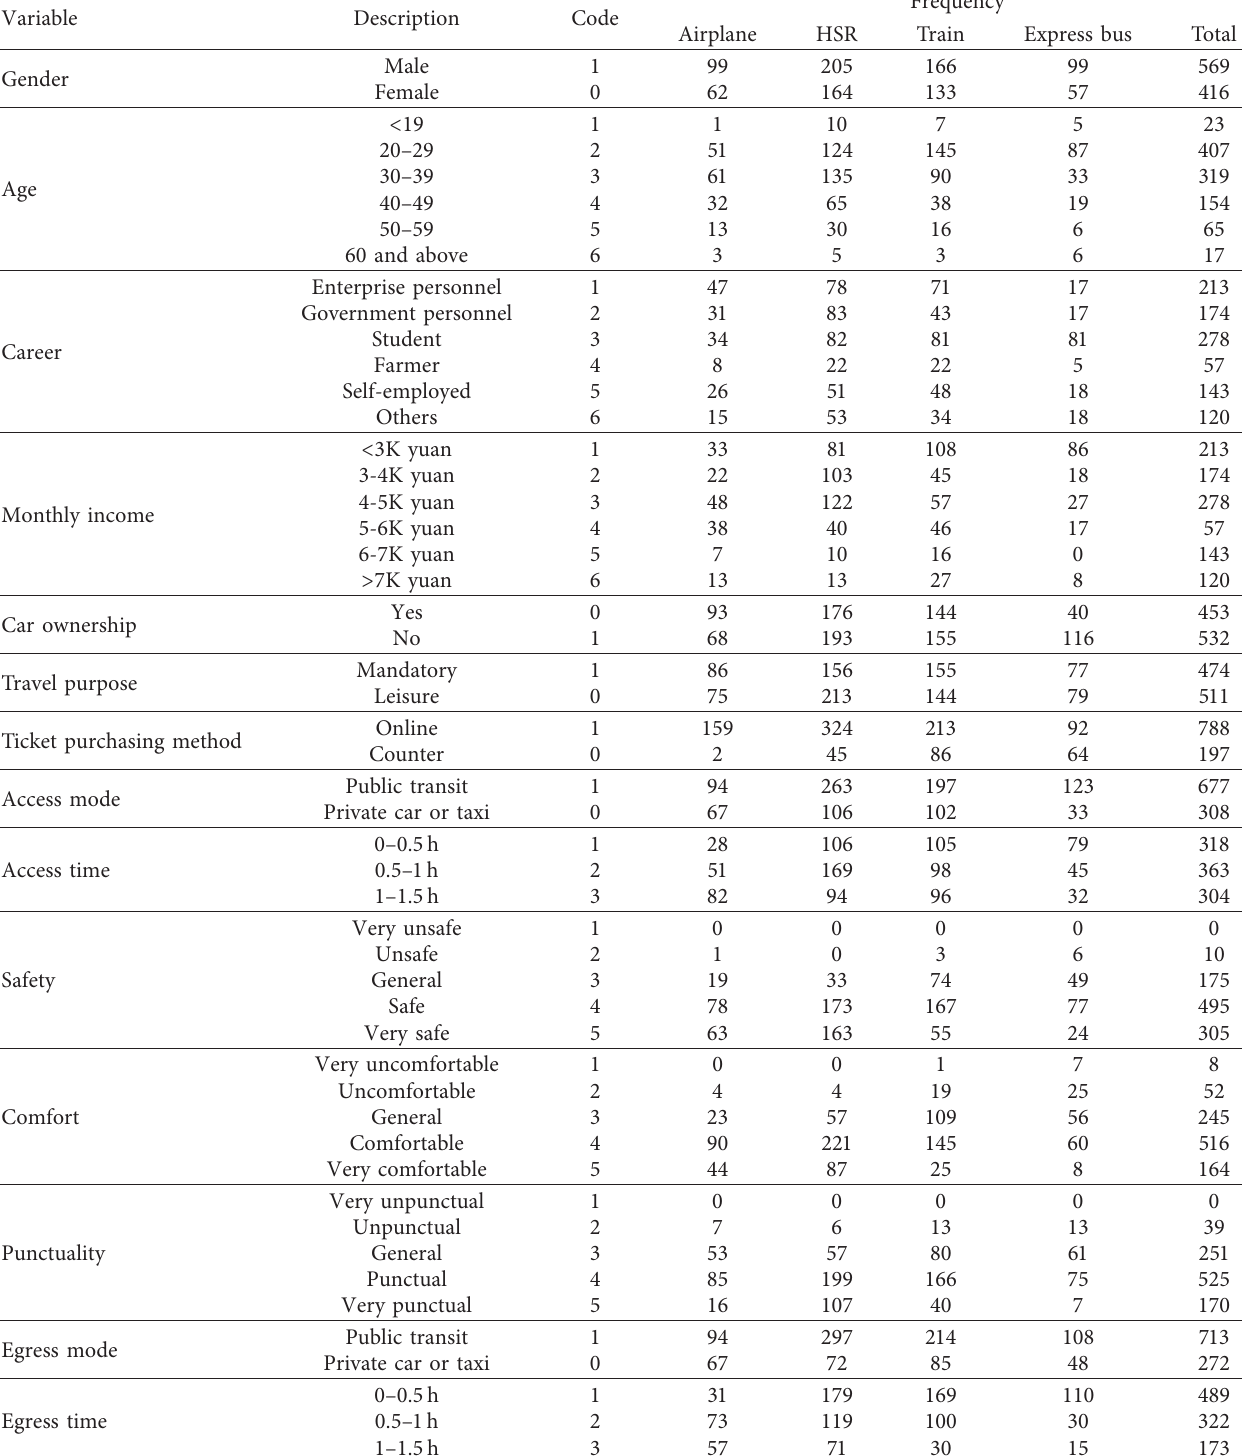
Table 2: Descriptions of category